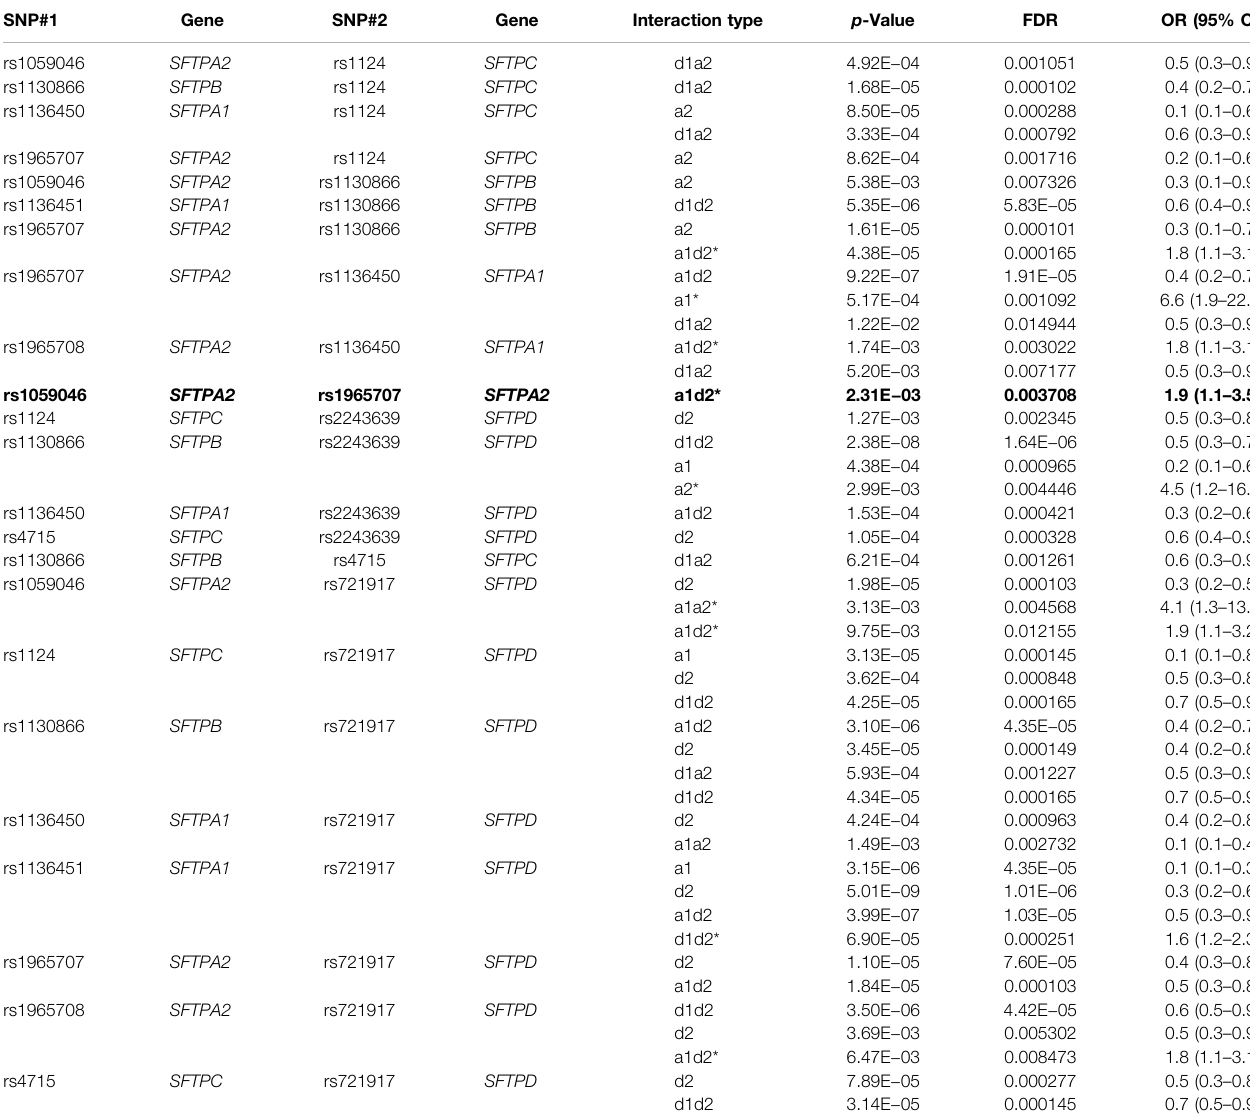
TABLE 5 | Associations of SP gene SNPs with persistent respiratory morbidity (PRM) at 12 months in a two-SNP model after adjusting for covariates (age, sex, race, and weight).